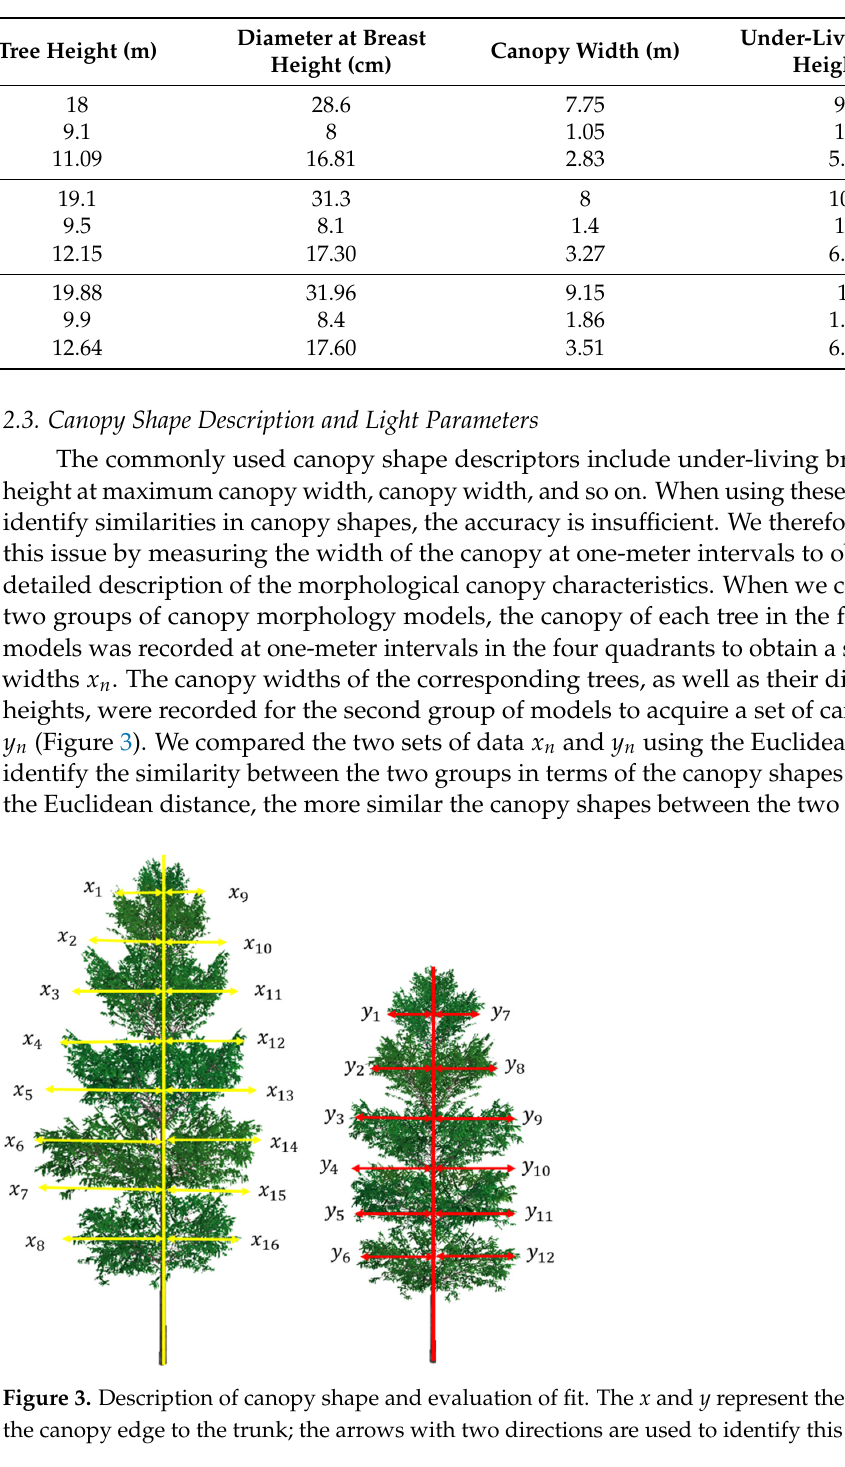
Table 1. Basic information of fir trees in sample site.